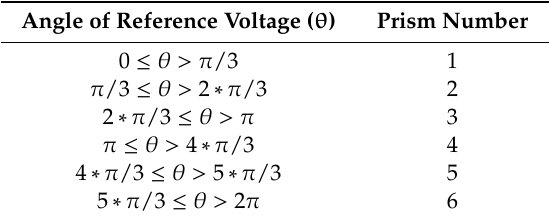
Table 1. Selection of the prism.